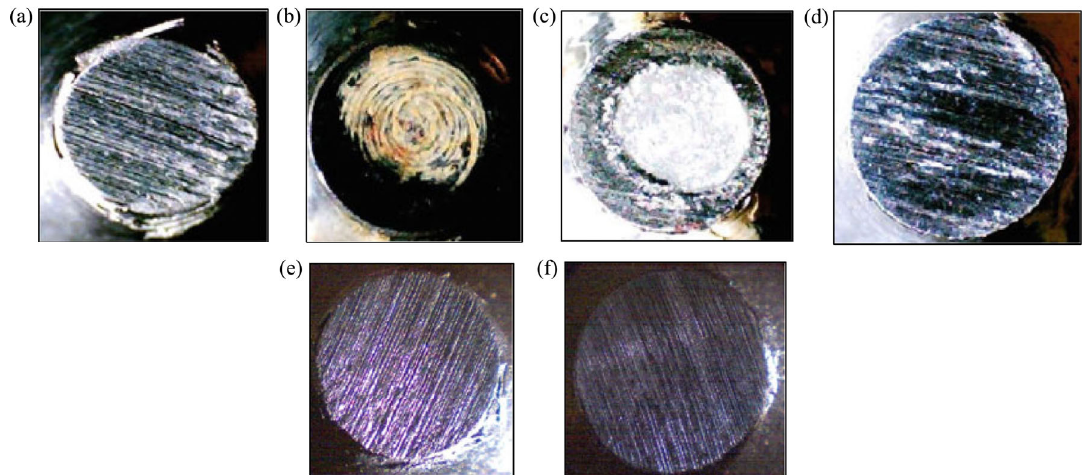
Fig. 18 Wear track images of the processed Ti64 test specimens (magnification:20×): (a) as-received; (b) water cooled; (c) air cooled; (d) furnace cooled (e) shot peened (3.5 bar) (f) shot peened (4.5 bar). Reproduced with permission from Ref. [3]. Copyright Springer Nature, 2012.